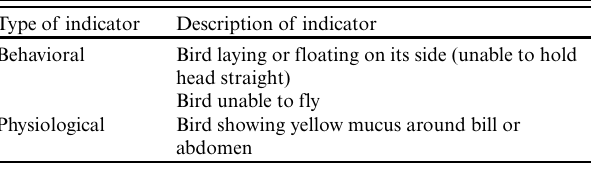
Table 4 . Observable indicators of avian disease reported by participants in Kimmirut, Cape Dorset, Coral Harbour, and Igloolik,